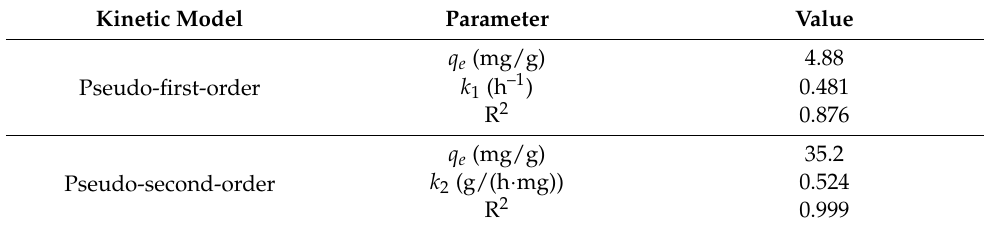
Table 4. Values of parameters for MO adsorption kinetic models.